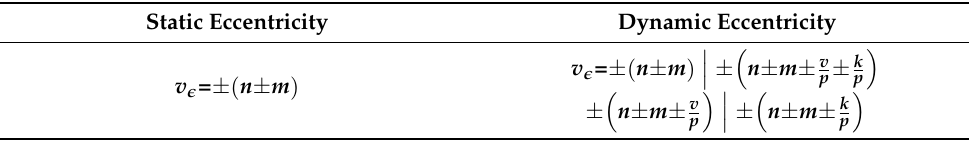
Table 10. Harmonics of the magnetic force in a machine with